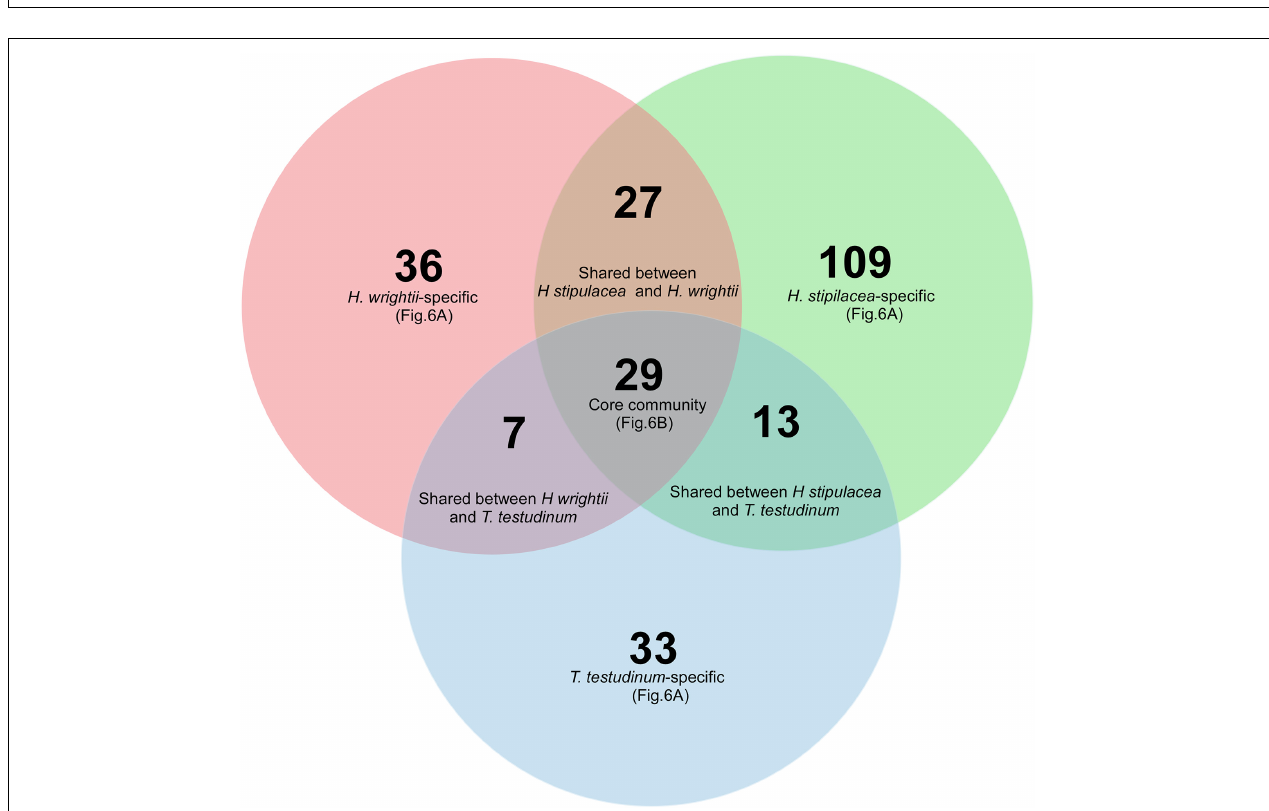
FIGURE 5 | Venn diagram representing core bacterial OTUs occurring in at least 80% of the seagrass samples of H. stipulacea (green), H. wrightii (red), and T. testudinum (blue) in both roots and leaves and the different intersections among them. OTUs specific to each seagrass species (species-specific) and OTUs common to all three seagrasses (“core of the core” community) are represented in Figure 6 at its order level.